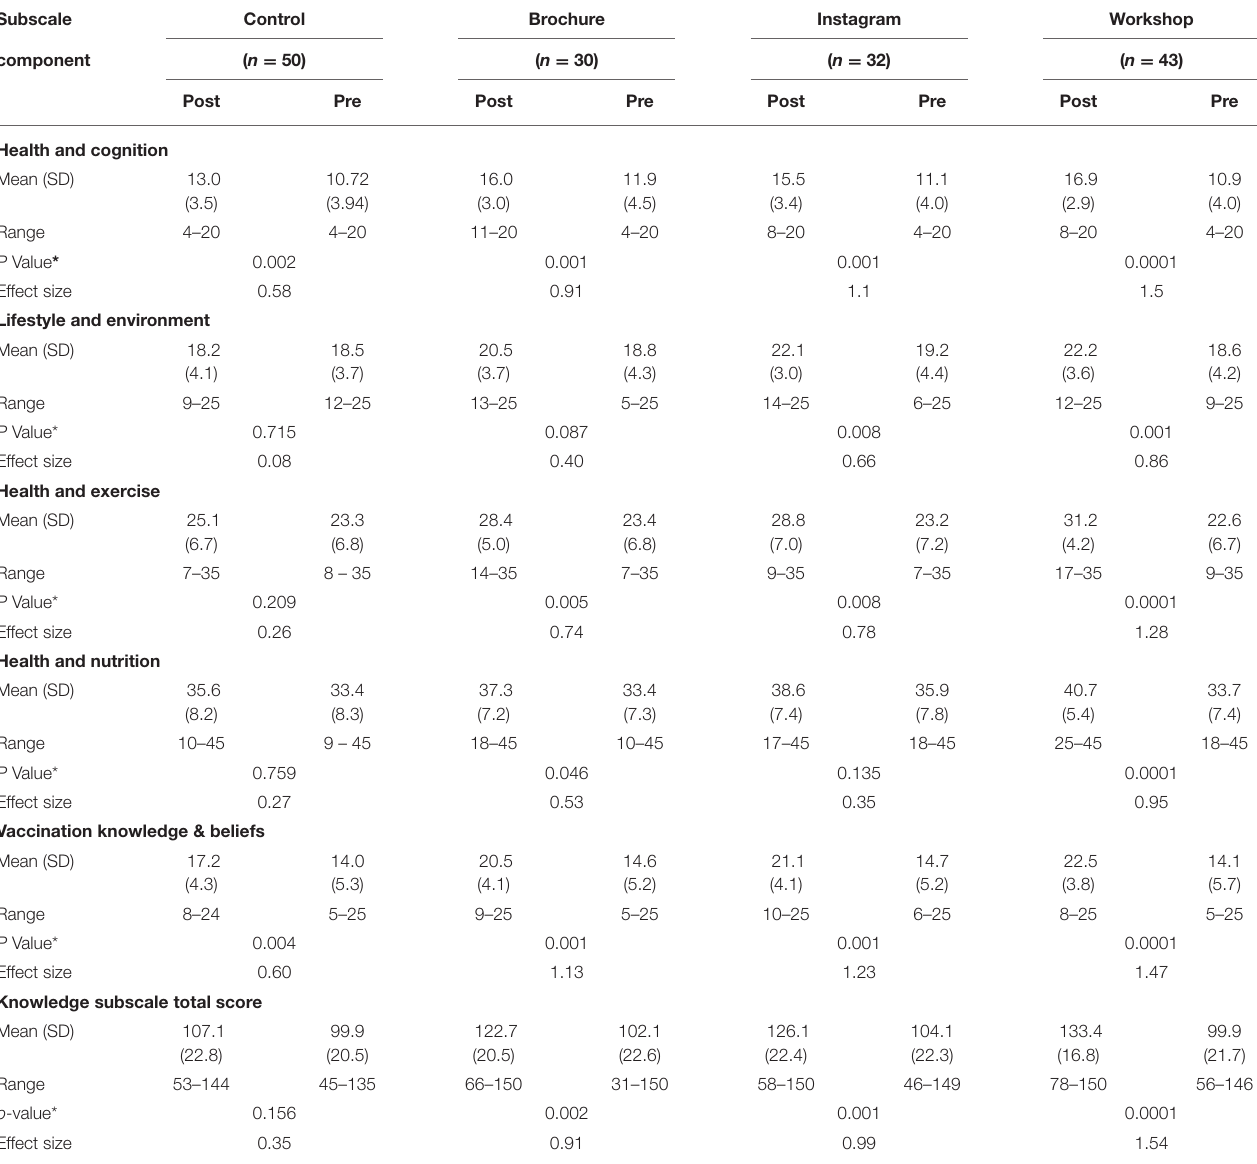
TABLE 3 | Participant’s knowledge subscale Pre-post (within